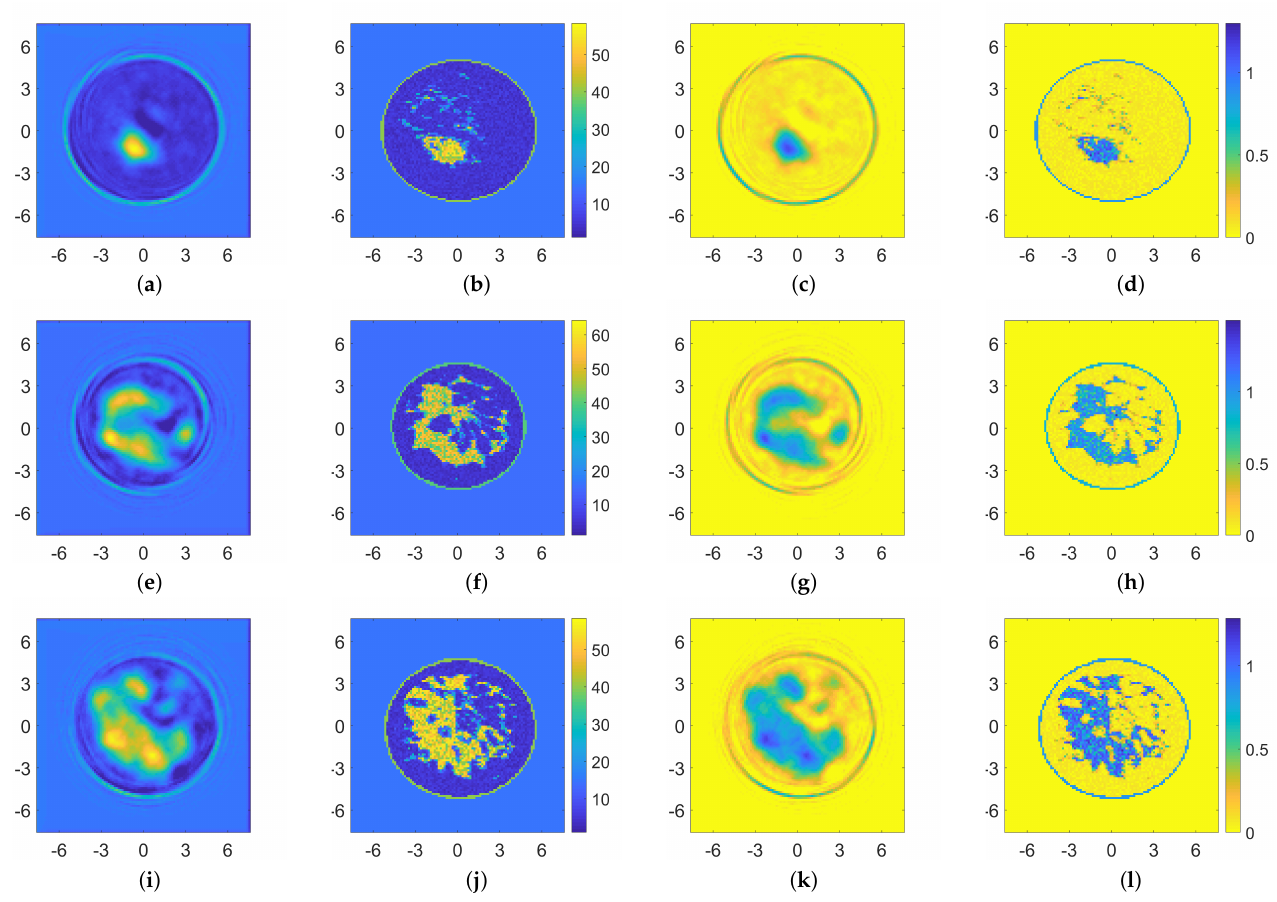
Figure 11. Recoveries obtained via the proposed ANN approach for some realistic breast phantoms proposed by [12,75]. Breast ID: 012204, slice 54: retrieved permittivity and conductivity maps ( a , c ) and reference ( b , d ). Breast ID: 062204, slices 47 and 71: retrieved permittivity and conductivity maps ( e , i , g , k ), and references ( f , j , h , l ), respectively. Table 5. Means and standard deviations of the considered quality metrics per each class of the testing population (6000 breast profiles in total). The number of profiles per class is reported in brackets).